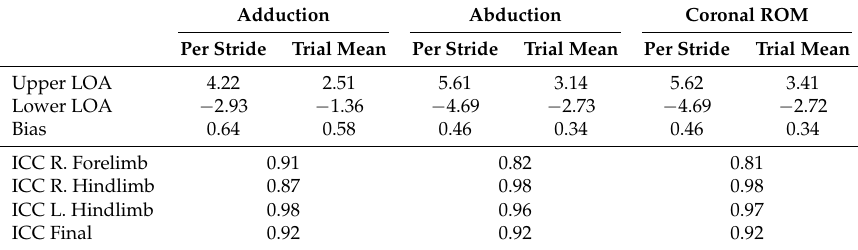
Table 4. Summary of measurement agreement statistics for the coronal limb angles at walk (values in